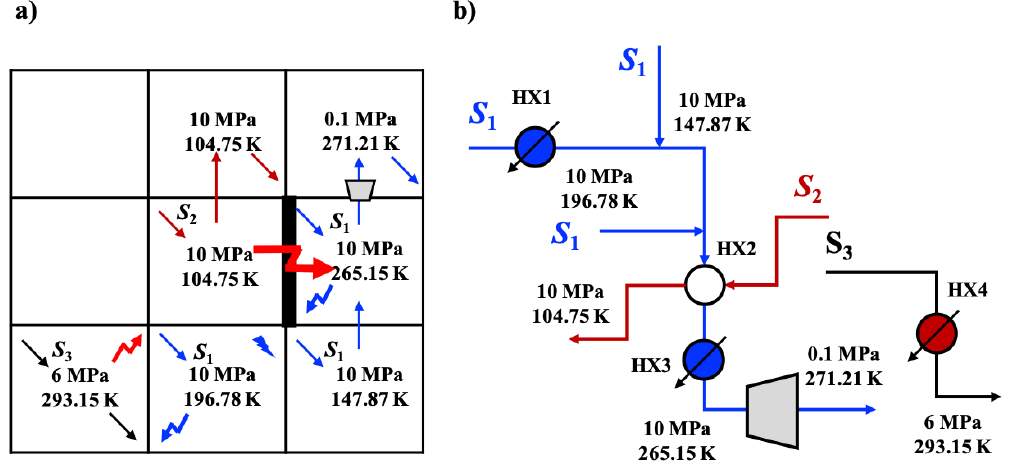
Figure 7. Resultant integrated work and heat exchanger network for the liquefied energy chain (case 1): ( a ) Bock representation; ( b ) Equivalent WHEN